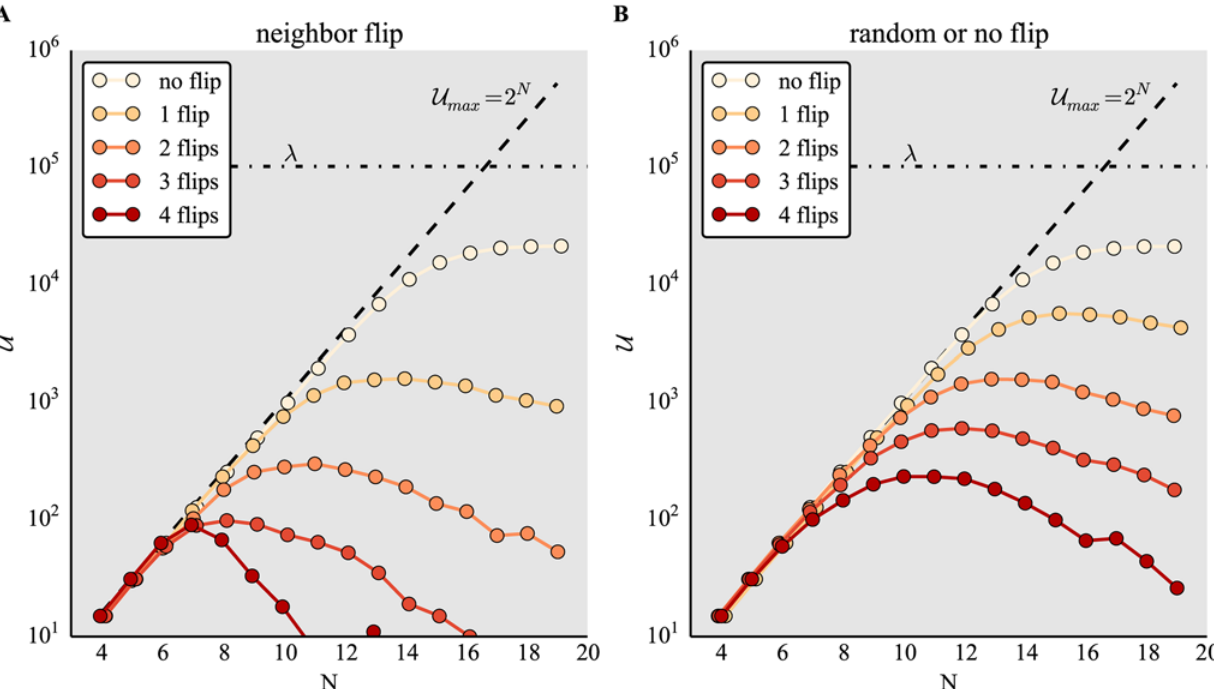
Fig 2. Effect of implementations of noise on phenotype discovery for k = 2. Number of unique phenotypes U accessed for different network sizes N and varying number of gene flips for noise models (A) neighbor flip and (B) random or no flip. Networks are random (not pre-selected for stability). Other parameters and dashed lines are as in Fig